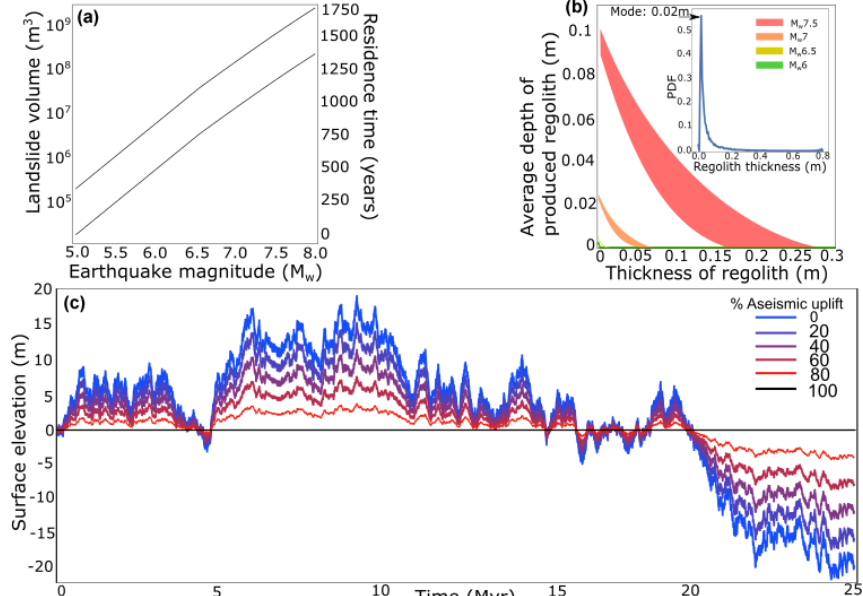
Figure 2. The average depth of regolith produced by an earthquake is impacted by the earthquake magnitude and the thickness of regolith that is on the hillslope before the earthquake occurs. (a) Scaling of landslide volume with magnitude from Malamud et al. (2004b) and the average residence time of landslide sediment in the Longmen Shan region based upon an erosion rate of 0.62mmyr − 1 . The two lines represent the minimum and maximum volumes of landsliding generated, within the bounds on Eq. (8). (b) Variability of regolith production, expressed as volume per area, with existing depth of regolith on the hillslope, for four representative earthquake magnitudes. Coloured areas represent the variability of the landslide volume produced by an earthquake, randomly sampling within the bounds of Eq. (8). These coseismic landslide regolith production functions (CLRPFs) emerge from the model rather than being set in advance, and the variability at each magnitude is driven by noise inherent in the relationship between magnitude and landslide size (Eq. 8). The inset shows the probability distribution function for regolith thickness across the whole model run, integrating the effects of the CLRPF through time. A small but non-zero spatially averaged modal regolith thickness persists, but significantly larger thicknesses regularly occur. (c) Variability of surface elevation through time for model runs with identical earthquake sequences but with varying additional proportions of aseismic uplift. The assumption of steady state prevents any long-term permanent uplift, and so all variations in surface elevation are driven by the sequence of earthquakes and changes in regolith thickness. Increasing the aseismic contribution to uplift reduces the uplift of large earthquakes, resulting in much less variable surface uplift and therefore